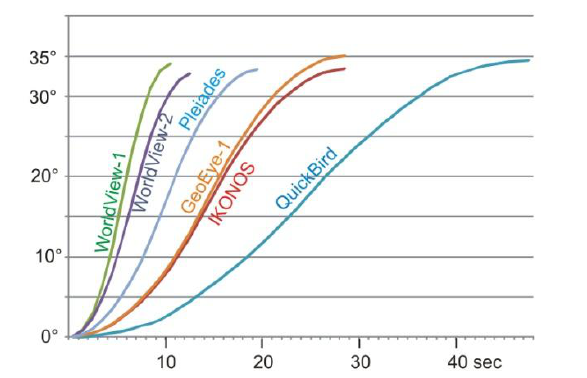
Figure 3. Slewing time with change of view direction/time The slewing time directly influences the imaging capacity. A faster slewing increases the possibility of selecting the